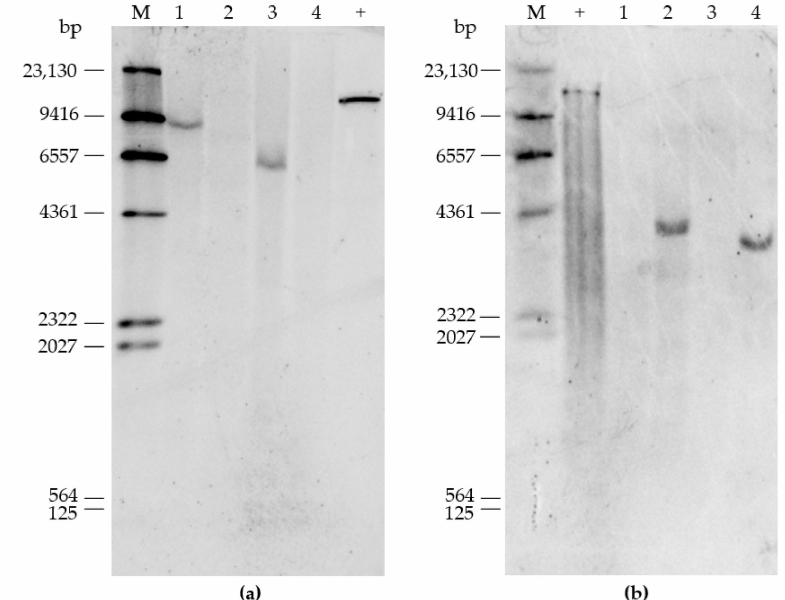
Figure 4. Southern blot analysis of SCB-29. ( a ) Hybridization with DIG-labeled cp4 epsps probe. M, DNA Molecular Weight Marker II, DIG-labeled. 1, gDNA of SCB-29 digested with Kpn I. 2, gDNA of non-transgenic maize digested with Kpn I. 3, gDNA of SCB-29 digested with Eco R V. 4, gDNA of non-transgenic maize digested with Eco R V. +, transformation vector digested with Kpn I. ( b ) Hybridization with DIG-labeled bar probe. M, DNA Molecular Weight Marker II, DIG-labeled. +, transformation vector digested with Kpn I. 1, gDNA of non-transgenic maize digested with Bam H I. 2, gDNA of SCB-29 digested with Bam H I. 3, gDNA of non-transgenic maize digested with Bgl II. 4, gDNA of SCB-29 digested with Bgl II.